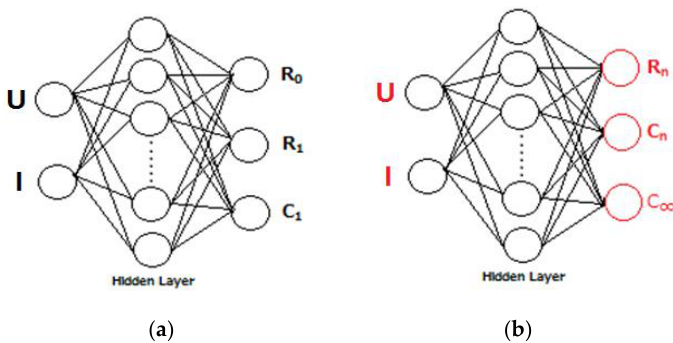
Figure 14. ANN structure for the proposed model: ( a ) structure used for high frequency region and ( b ) structure used for low frequency region. structure used for low frequency region.